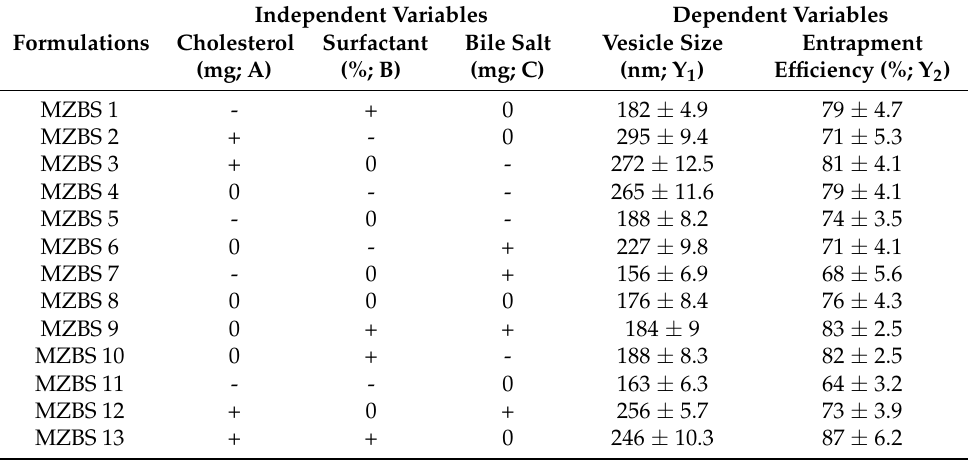
Table 2. Composition of miconazole bilosomes (MZBSs) with their mean vesicle size and entrap- ment